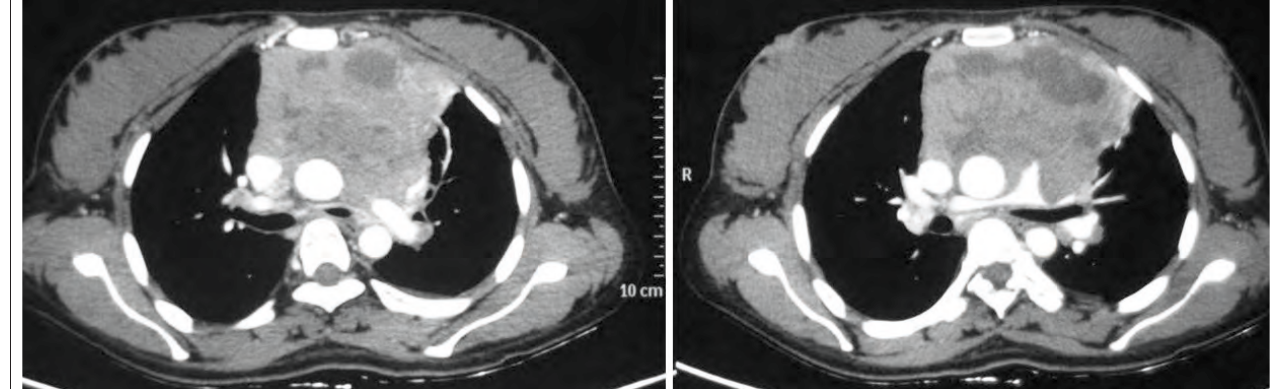
Fig. 11. Axial CT image in a 30-year-old woman showing heterogenously enhancing anterior mediastinal mass with cystic/necrotic changes in a proven case of nonseminomatous germ cell